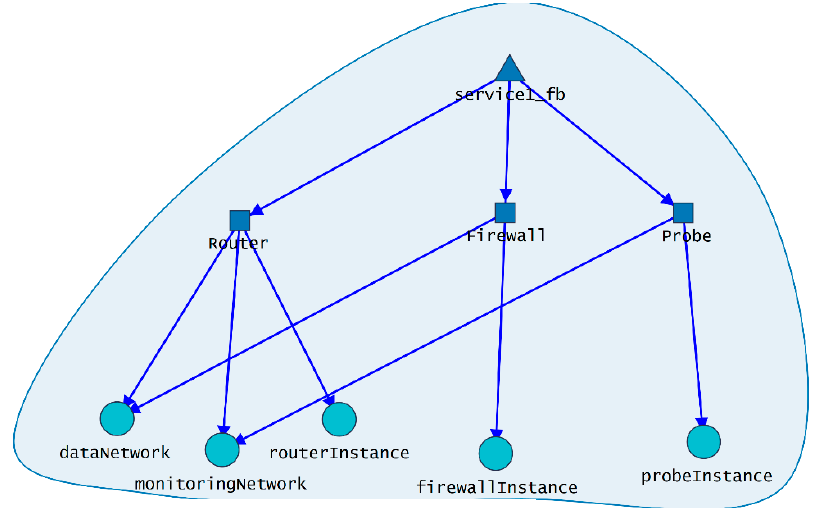
Figure 14. RFBisation of service deployment.